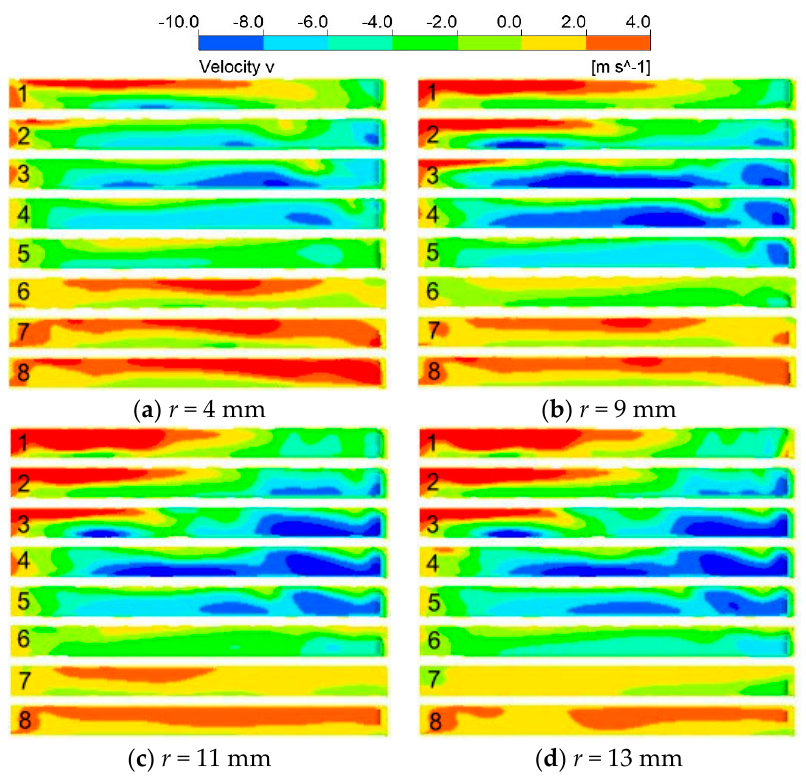
Figure 13. Distribution of v -velocity in the blade passages near the volute tongue.